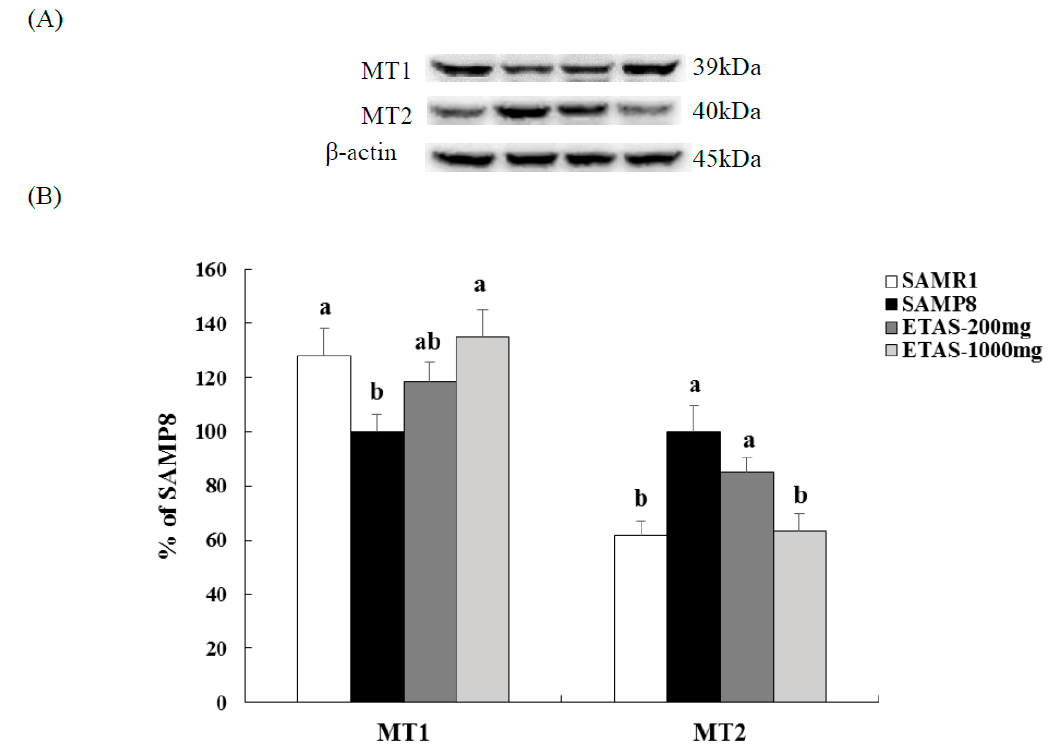
Figure 5. MT1 and MT2 expressions in the hypothalamus of 3-month-old male mice fed with a different diet for 12 weeks. ( A ) Electrophoretograms of MT1, MT2 and β -actin expressions. ( B ) MT1 and MT2 expression of different groups. The y axis denotes the percentage of each group compared to the SAMP8 control group. Values were mean ± S.E.M. (n = 8/group). Data with different superscripts are significantly different among groups.